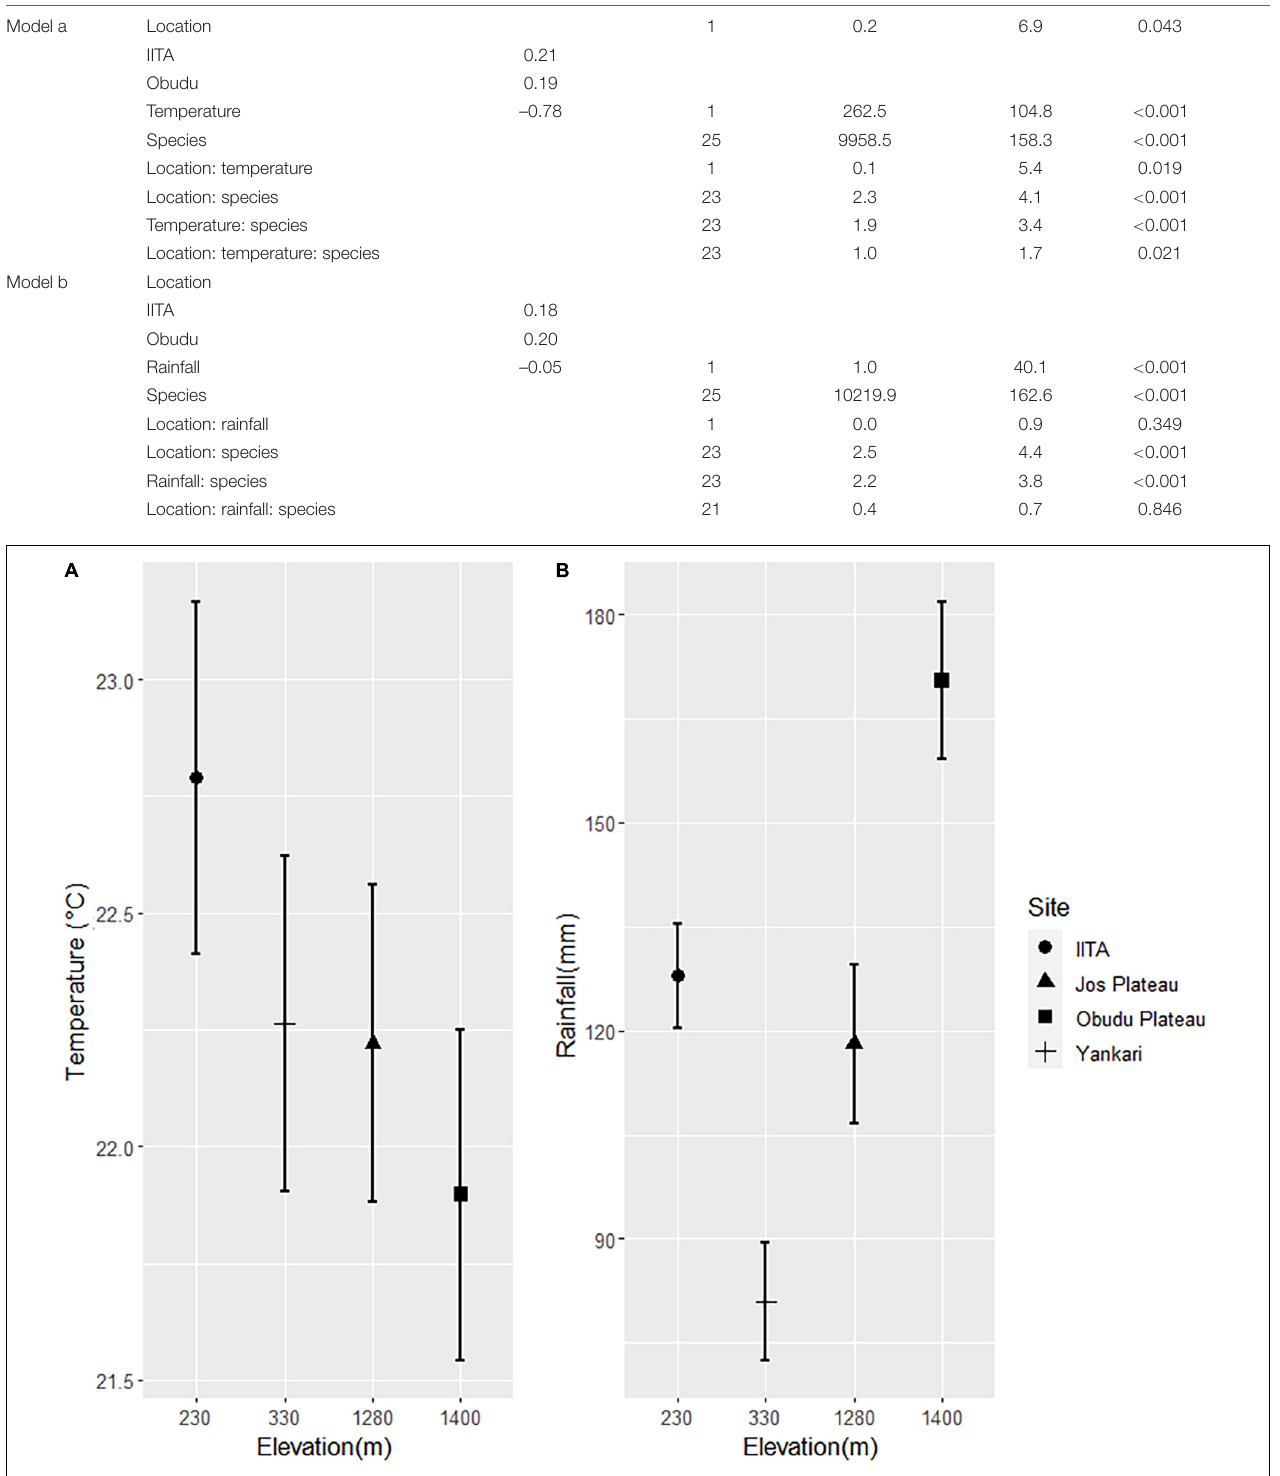
FIGURE 4 | Mean temperature (A) and rainfall (B) ranges across elevation gradients.